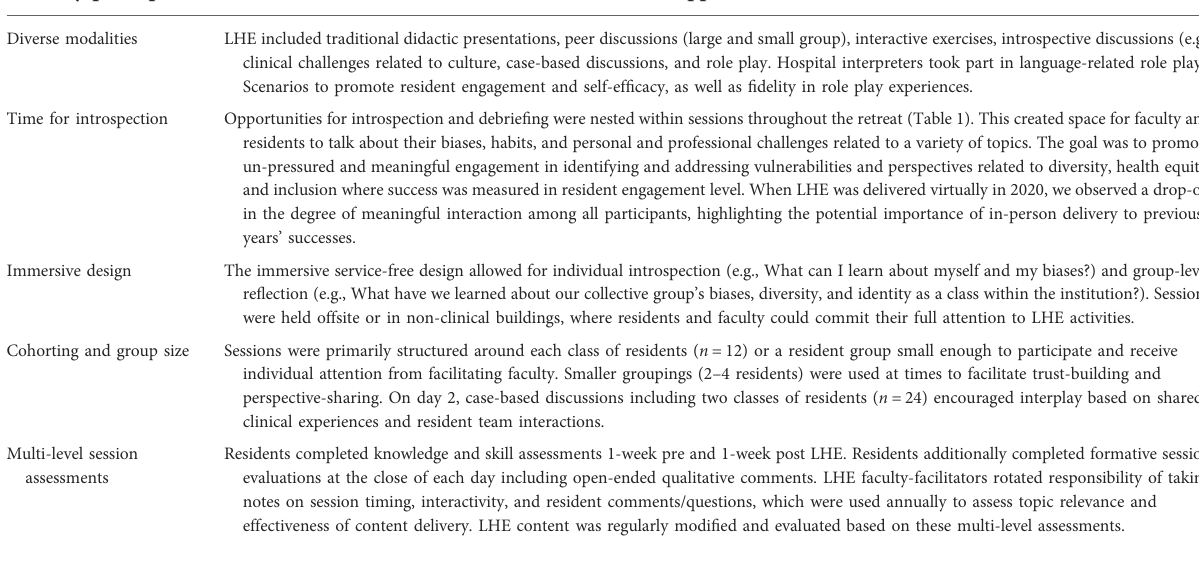
TABLE 1C Leaders in Health Equity (LHE) delivery principles and detailed approaches.